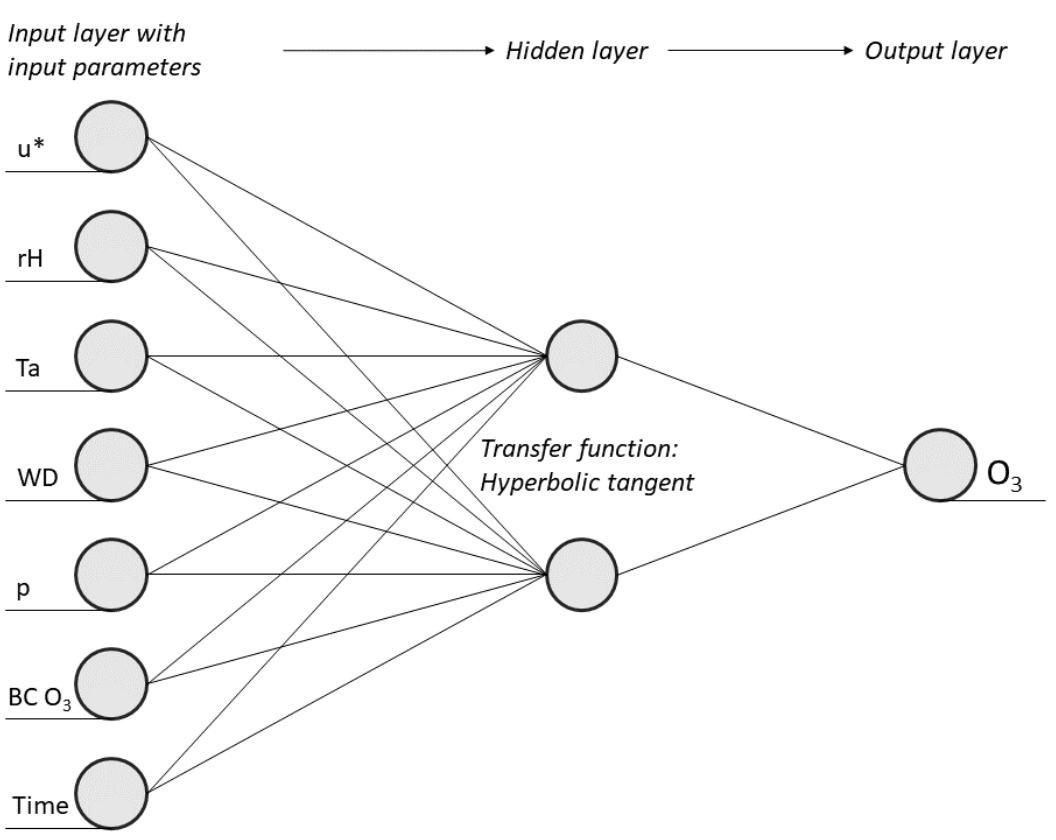
Figure 4. Architecture of the Multilayer Perceptron (MLP) to predict O 3 concentrations. BC = background concentration.